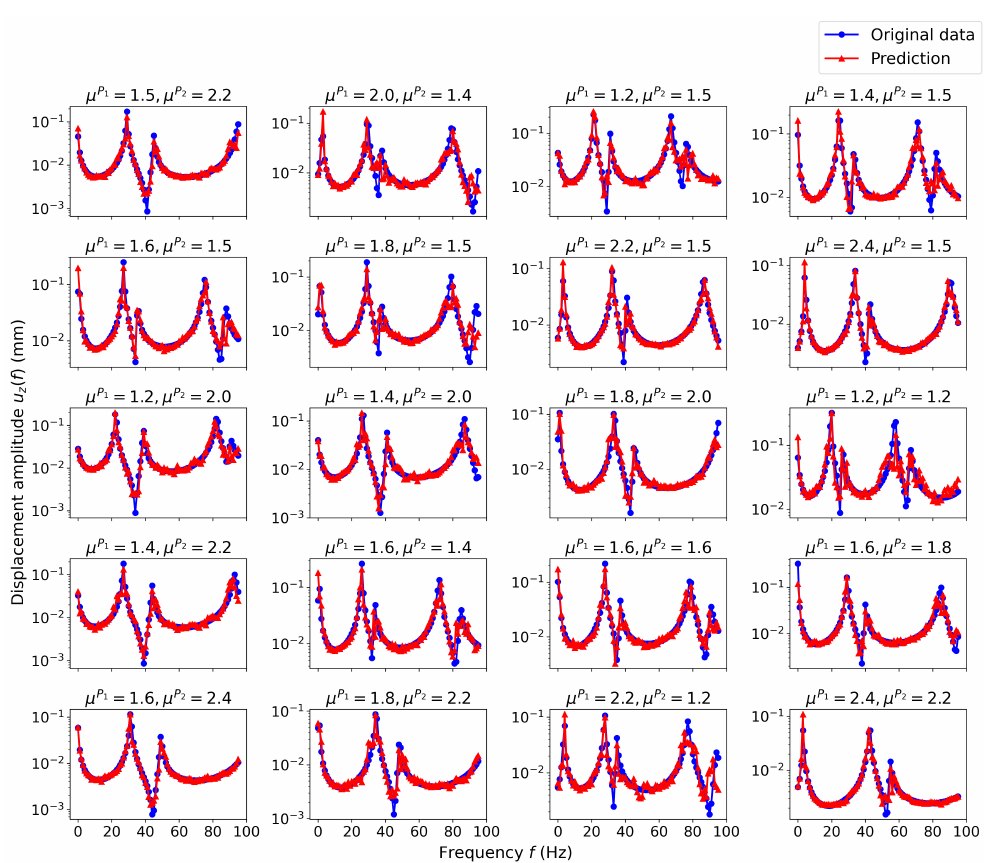
on the testing set. 3